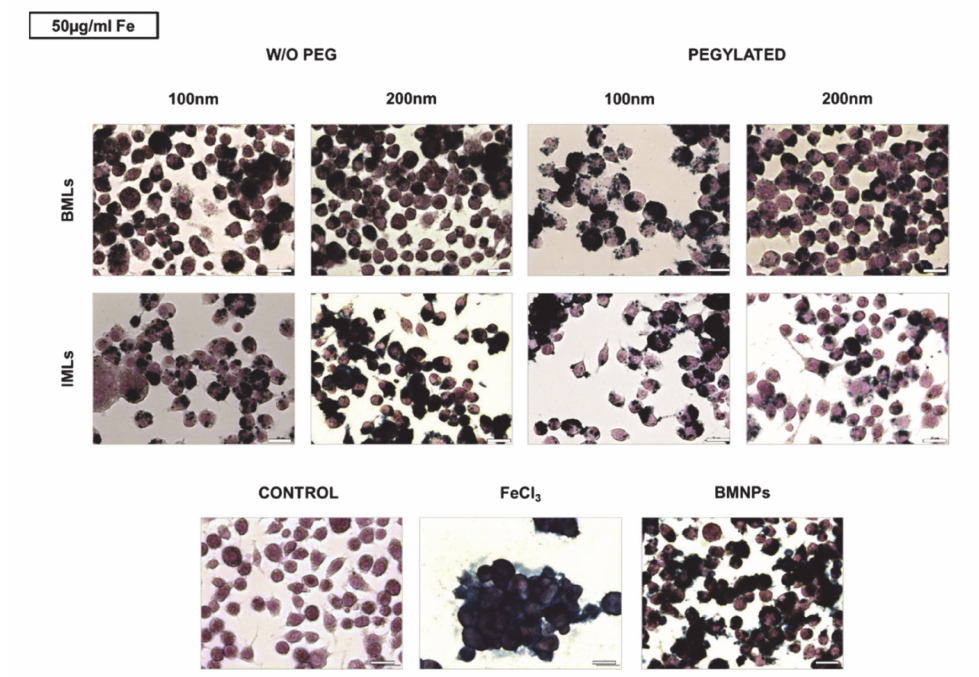
Figure 4. Internalization of BMLs and IMLs in RAW 264.7 cells. Representative images of RAW 264.7 cells exposed to 50 µ g / mL Fe of BMLs and IMLs (pegylated or not), BMNP (magnetic core) and Fe for 24 h and stained with Prussian blue. Scale bar 25 µ